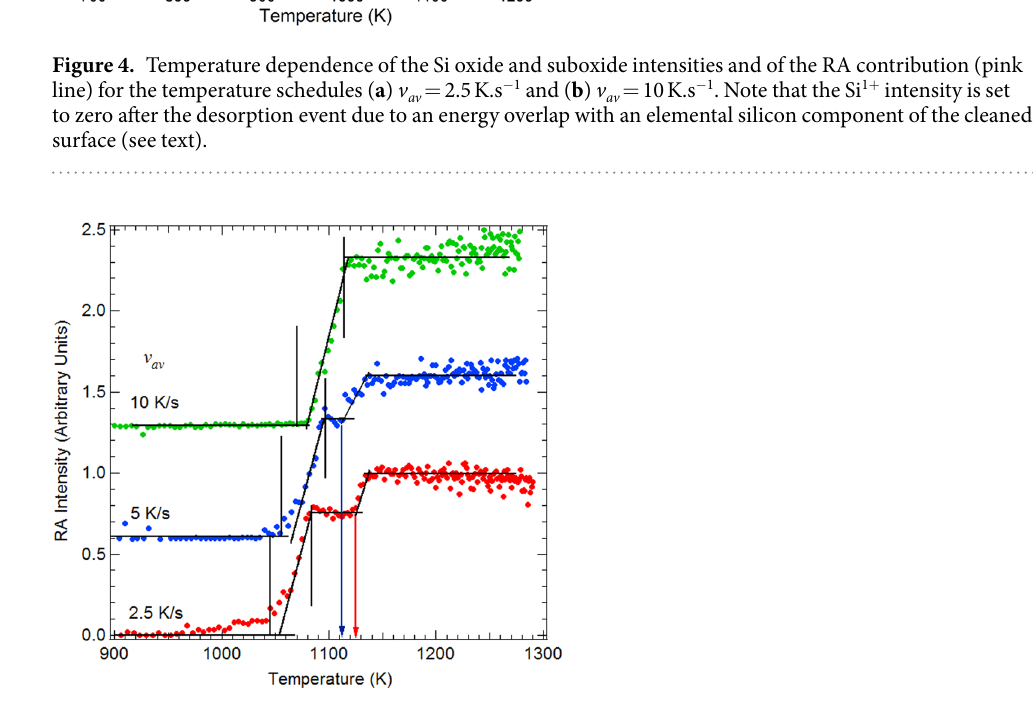
the metastable interface states Si 2 + , modifying the decomposition process. Similarly, high heating rates could